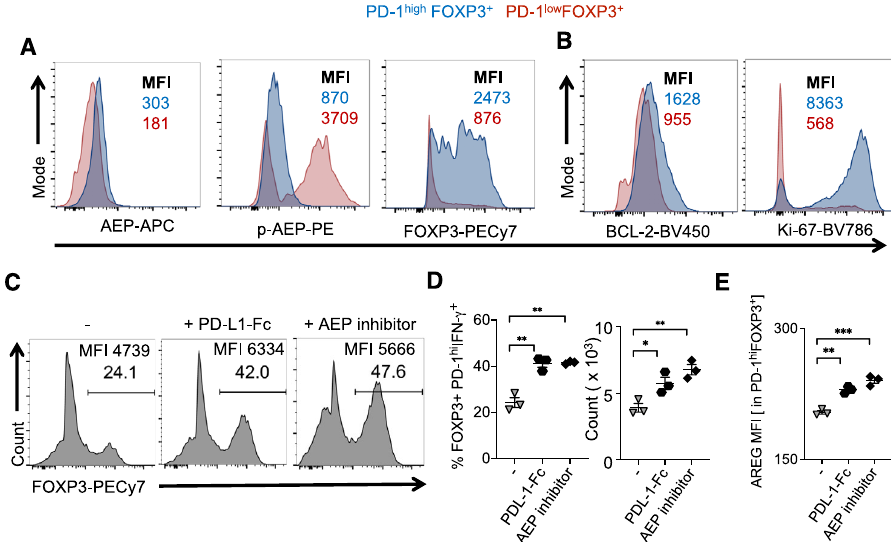
Fig. 6 PD-1 ligation downmodulates asparaginyl endopeptidase (AEP) and stabilizes the expression of FOXP3 and AREG. CD4 + T cells were stimulated as in Fig. 5. A , B AEP, pAEP, FOXP3, BCL-2, and Ki-67 staining in PD-1 high FOXP3 + (blue) and PD-1 low FOXP3 + cells 6 days post-infection. Some CD4 + T cells stimulated and infected as above were moved to a plate coated with recombinant human PD-L1/B7-H1 Fc chimera (5 μ g/ml) or treated with AEP inhibitor (10 μ M) 36 h after infection. Percentage of FOXP3 + cells in CD4 + population and FOXP3 MFI on FOXP3 + gated cells ( C ), percentage and absolute cell numbers of PD-1 hi IFN- γ + cells in FOXP3 + population ( D ), and AREG expression in FOXP3 + cells ( E ), as determined by fl ow cytometric analyses. Results represent triplicate experiments with similar results and are presented as mean value + / − SEM (ordinary one-way ANOVA and multiple t